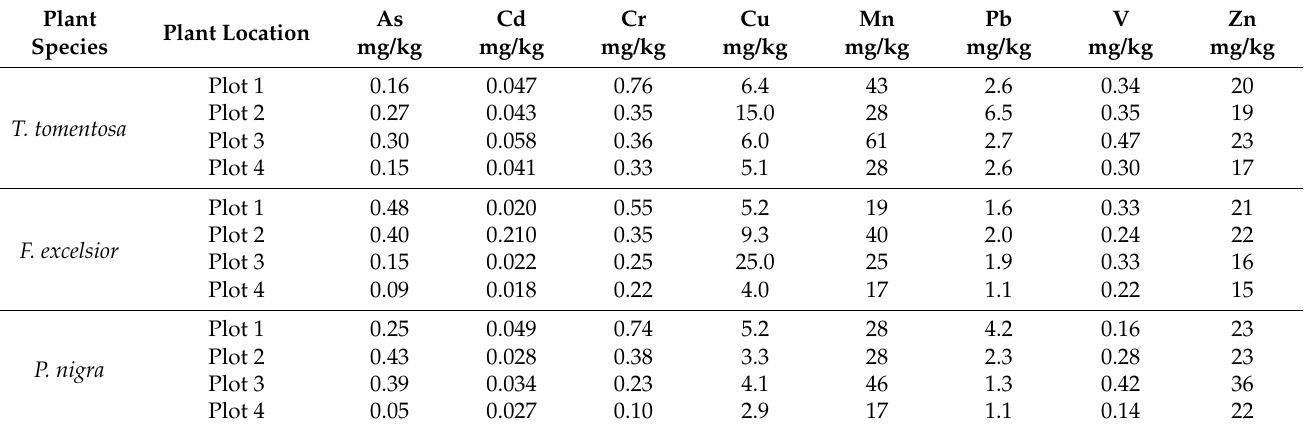
Table 4. Concentrations of some potentially toxic elements (PTEs) in tree leaves/needles (in mg/kg) in August 2020—6 years after transplantation into the urban